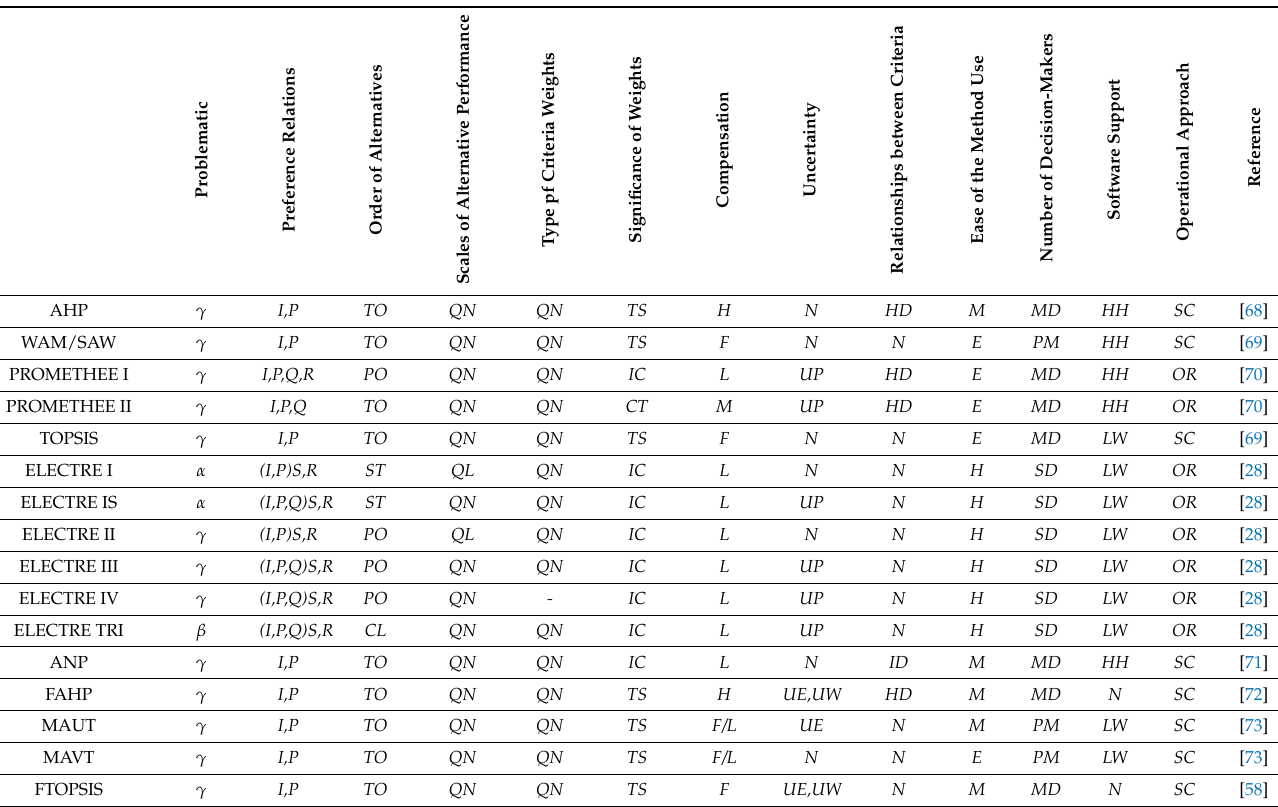
Table 3. Analysis of the features of multi-criteria methods that determine their application in sustainability